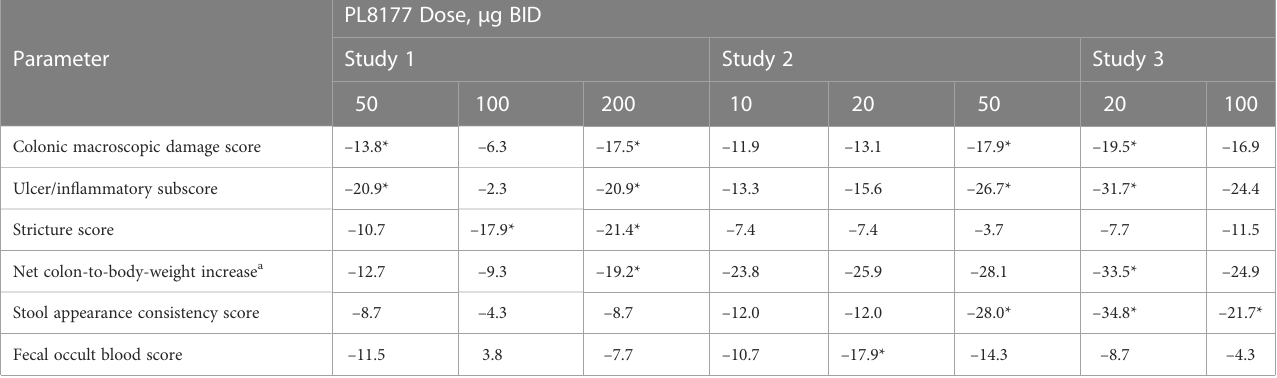
TABLE 1 Percentage difference from vehicle in colon observations on day 8 across studies and PL8177 doses in DNBS colitis – induced rats.